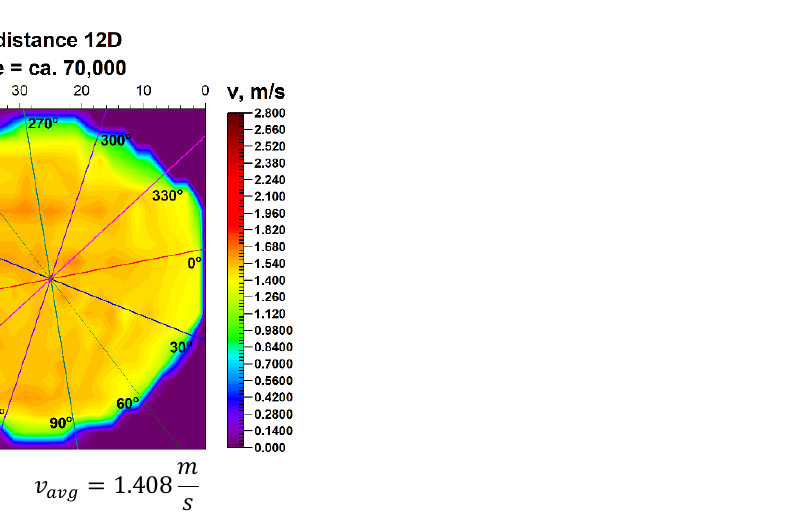
Figure 22. Velocity block at the distance 12D from the disturbance obtained by means of LDA measurements for Re ≅ 100,000.